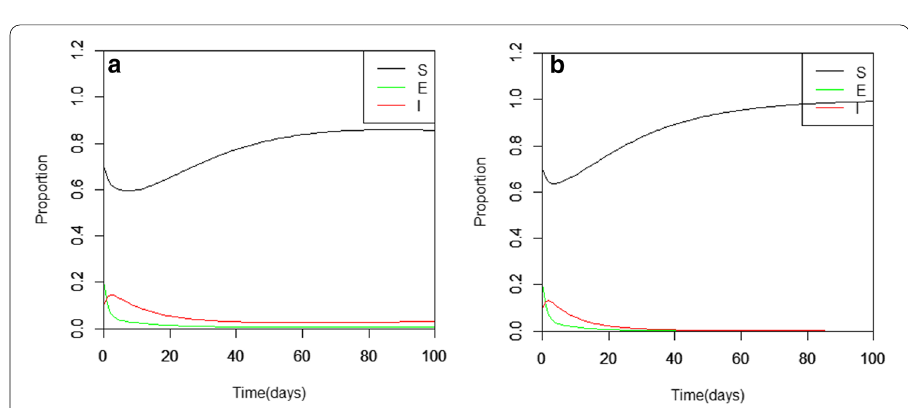
Fig. 3 The latent infection SEIR model effects, where κ = 0.3 ( a ) and κ = 0.1 ( b